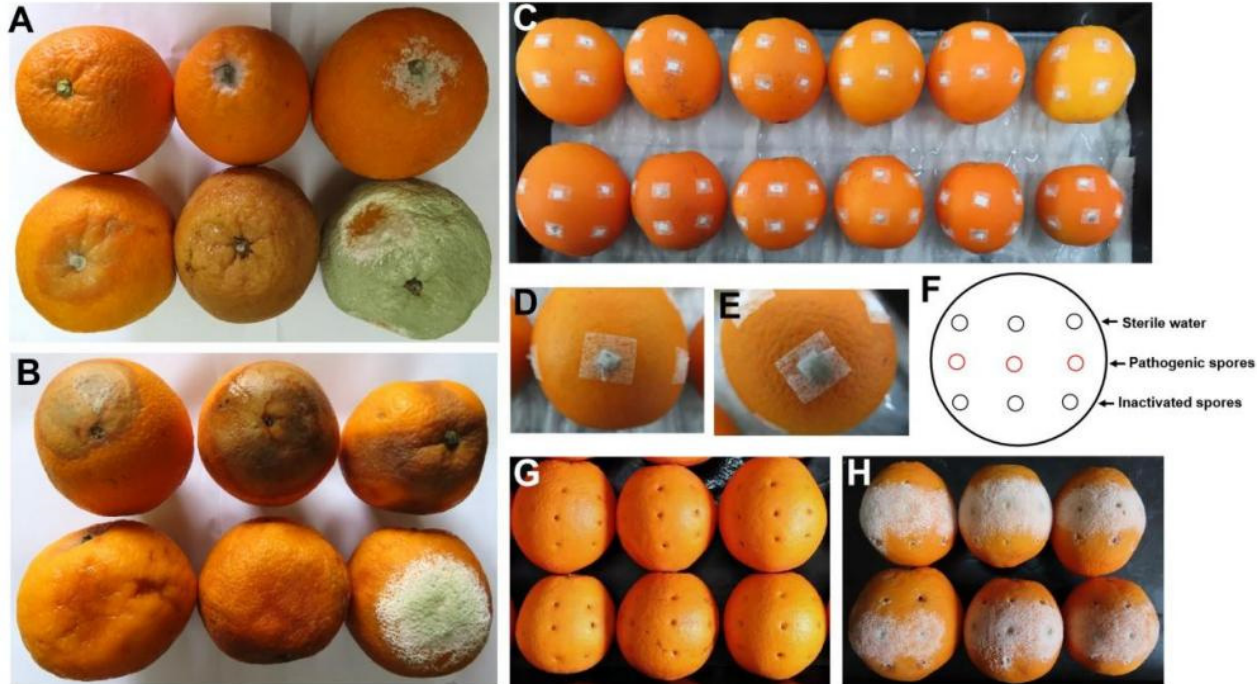
Figure 3. Fruit rot after 6 months of storage at 5 °C and after in vivo inoculation of pathogenic spores. ( A ). During storage, the mold slowly infected the fruit pedicle and caused the entire fruit to rot after 6 months of storage at 5 °C. ( B ) Mechanical damage on the fruits’ surface resulted in rot after 6 months of storage at 5 °C. ( C ) Noninvasive inoculation of the fruit surface with filter paper containing pathogen spore solution. ( D , E ) Enlarged view of the fruit with moldy patches. ( F ) Dia- gram of in vivo drilling inoculation of fruit surface. The first row of holes was inoculated with sterile water (negative control) and had no decayed phenotype. The second row was inoculated with untreated pathogenic spores (positive control), and the third row was inoculated with a spore suspension of pathogen inactivated by 10 min treatment of low-temperature plasma produced by the ionization of oxygen. ( G ) Initial phenotype of the fruit after in vivo drilling inoculation. ( H ) Fruit rot in the second row after 3 d of drill damage inoculation at 26 °C.